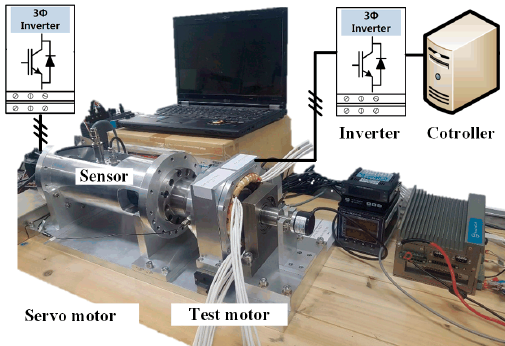
Figure 6. Experimental setup.